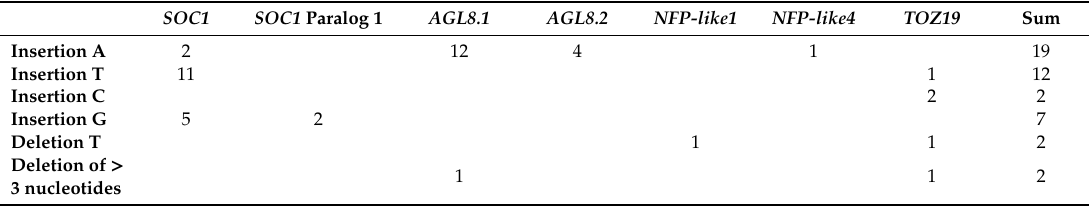
Table 6. Detailed view on the distribution of homozygous editings. Focused on the revealed 44 homozygous target editings, the most frequent event was the insertion of A or T. Single base deletions or found deletions larger than three nucleotides occurred rarely. For the editing of SOC1 Paralog 2 and NFP-like3 , no homozygous mutations have been